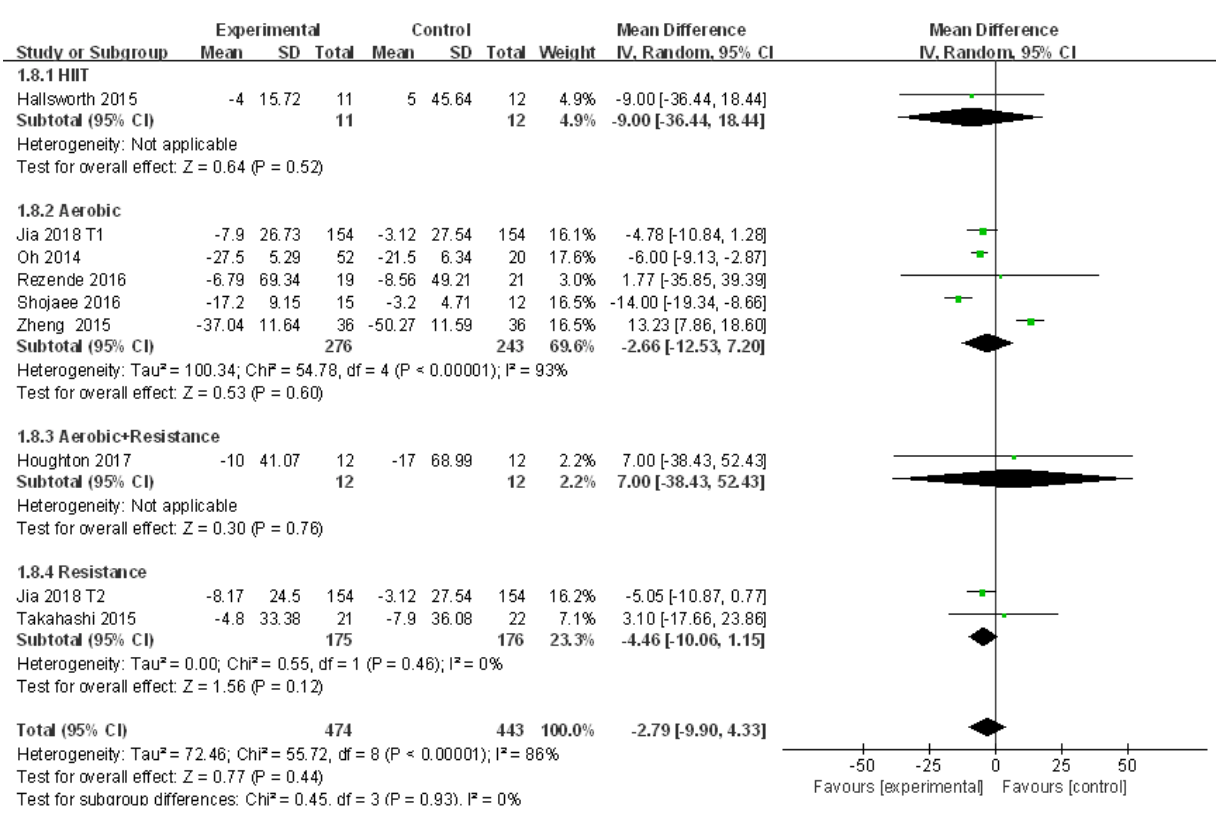
Figure 9. Subgroup analysis of different exercise styles on γ -glutamyl transpeptidase (GGT).